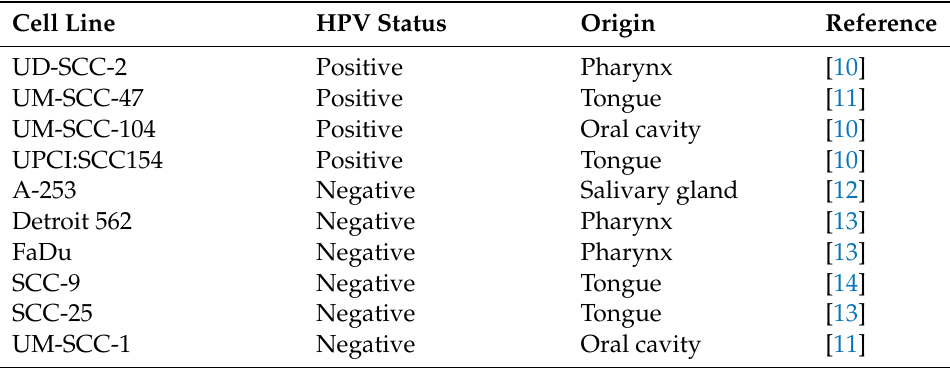
Table 1. Cell lines used in this